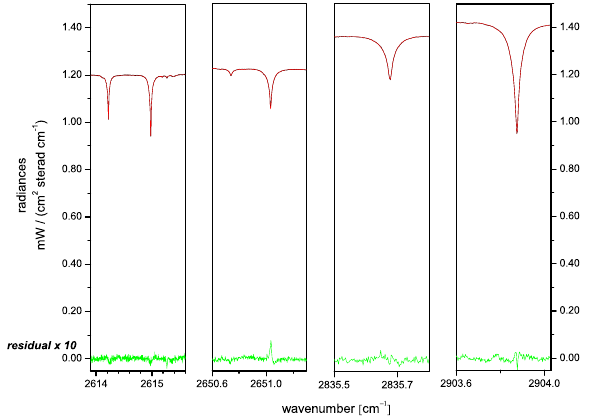
Fig. 2. The four applied spectral microwindows: measured spec- trum (black), simulated spectrum (red), and residuals multiplied by a factor of 10